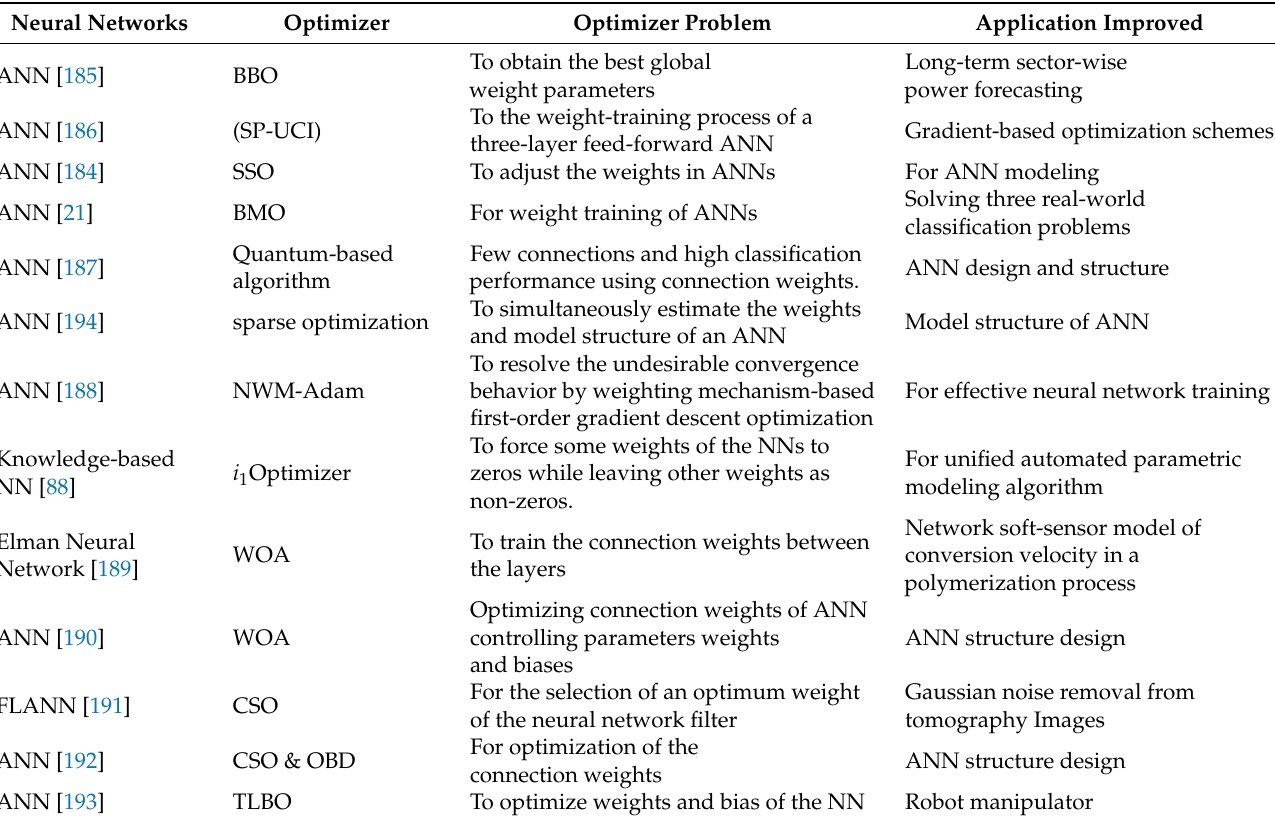
Table 9. Overview of a variety of optimization-based neural network weights optimization enhancement. Neural